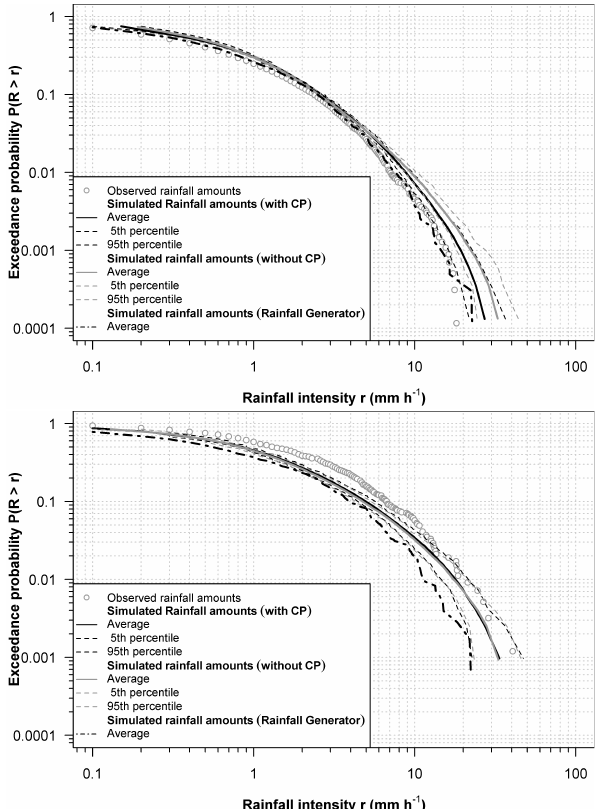
Fig. 8. Cumulative distribution functions of hourly rainfall amounts from observations and synthetic time series as generated by the cas- cade models (with and without CP) and the rainfall generator for pa- rameterization period 1989–1999 (top) and validation period 1969– 1979